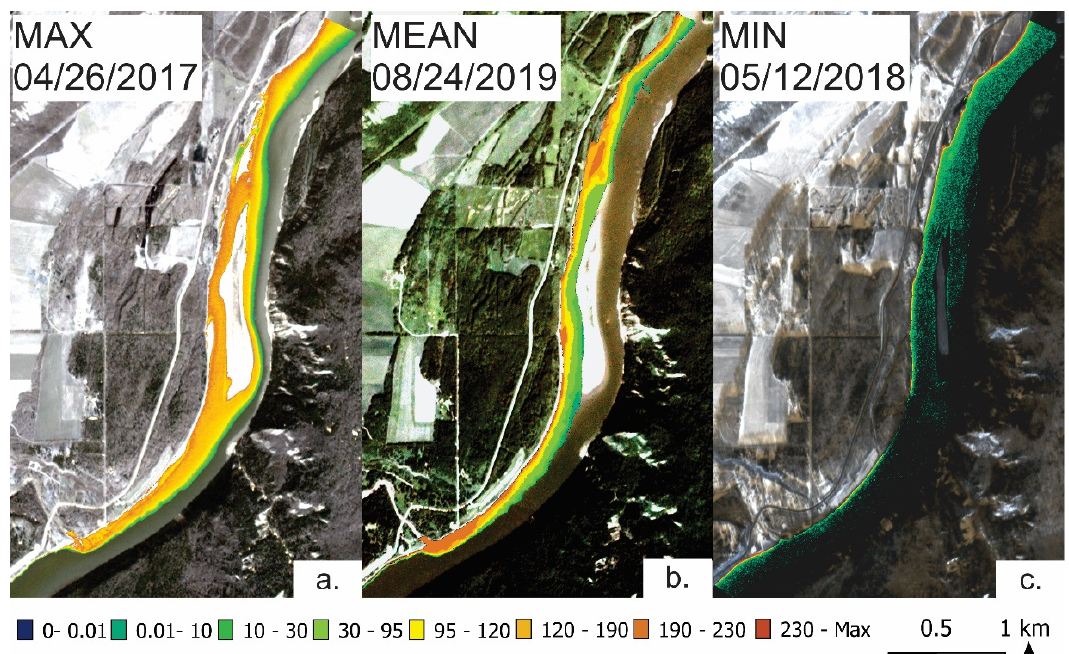
Figure 3. Suspended sediment concentration (mg/L) during ( a ) maximum, ( b ) mean, and ( c ) minimum plume magnitude (the product of plume area and mean concentration). Imagery courtesy of Planet Labs, Inc.